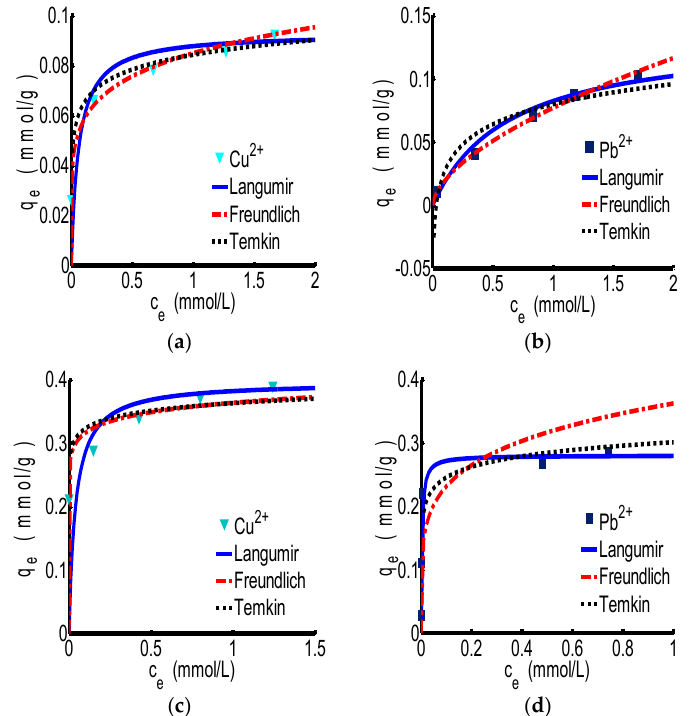
Figure 2. The adsorption isotherm of ChW and PTW. ( a ) ChW-Cu 2+ ; ( b ) ChW-Pb 2+ ; ( c ) PTW-Cu 2+ ; and ( d ) PTW-Pb 2+ .